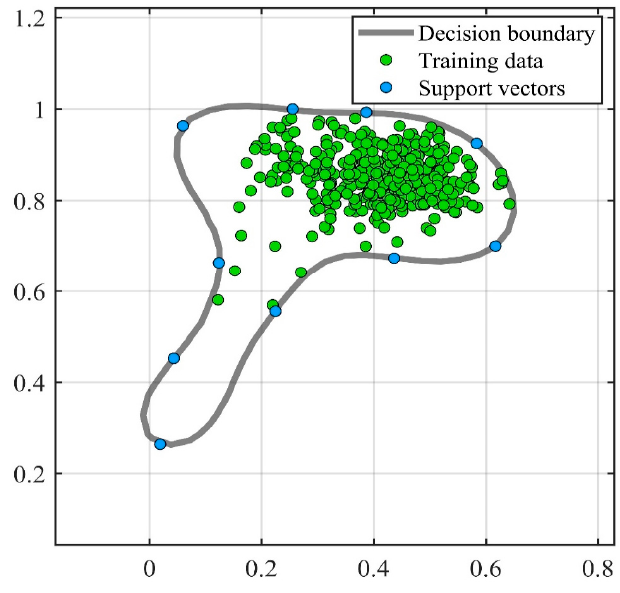
Figure 9. Results of training.